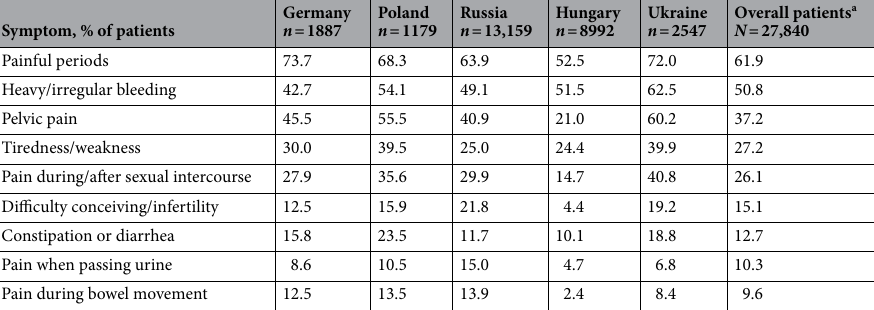
Table 2. Proportion of patients who experienced endometriosis-associated symptoms at study enrollment. a Patients from Switzerland are not presented here as a subcategory owing to low patient numbers ( n = 74). a Data obtained from patients receiving dienogest 2 mg/day, or other approved or non-approved medications for the treatment of endometriosis.